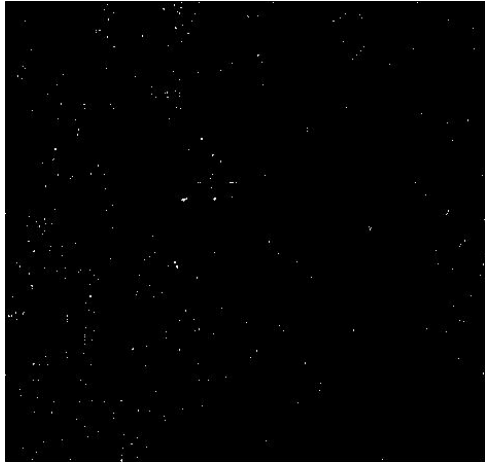
Figure 11. Gaussian noise field (top picture) and the result of binarization (bottom picture) with threshold level equals to